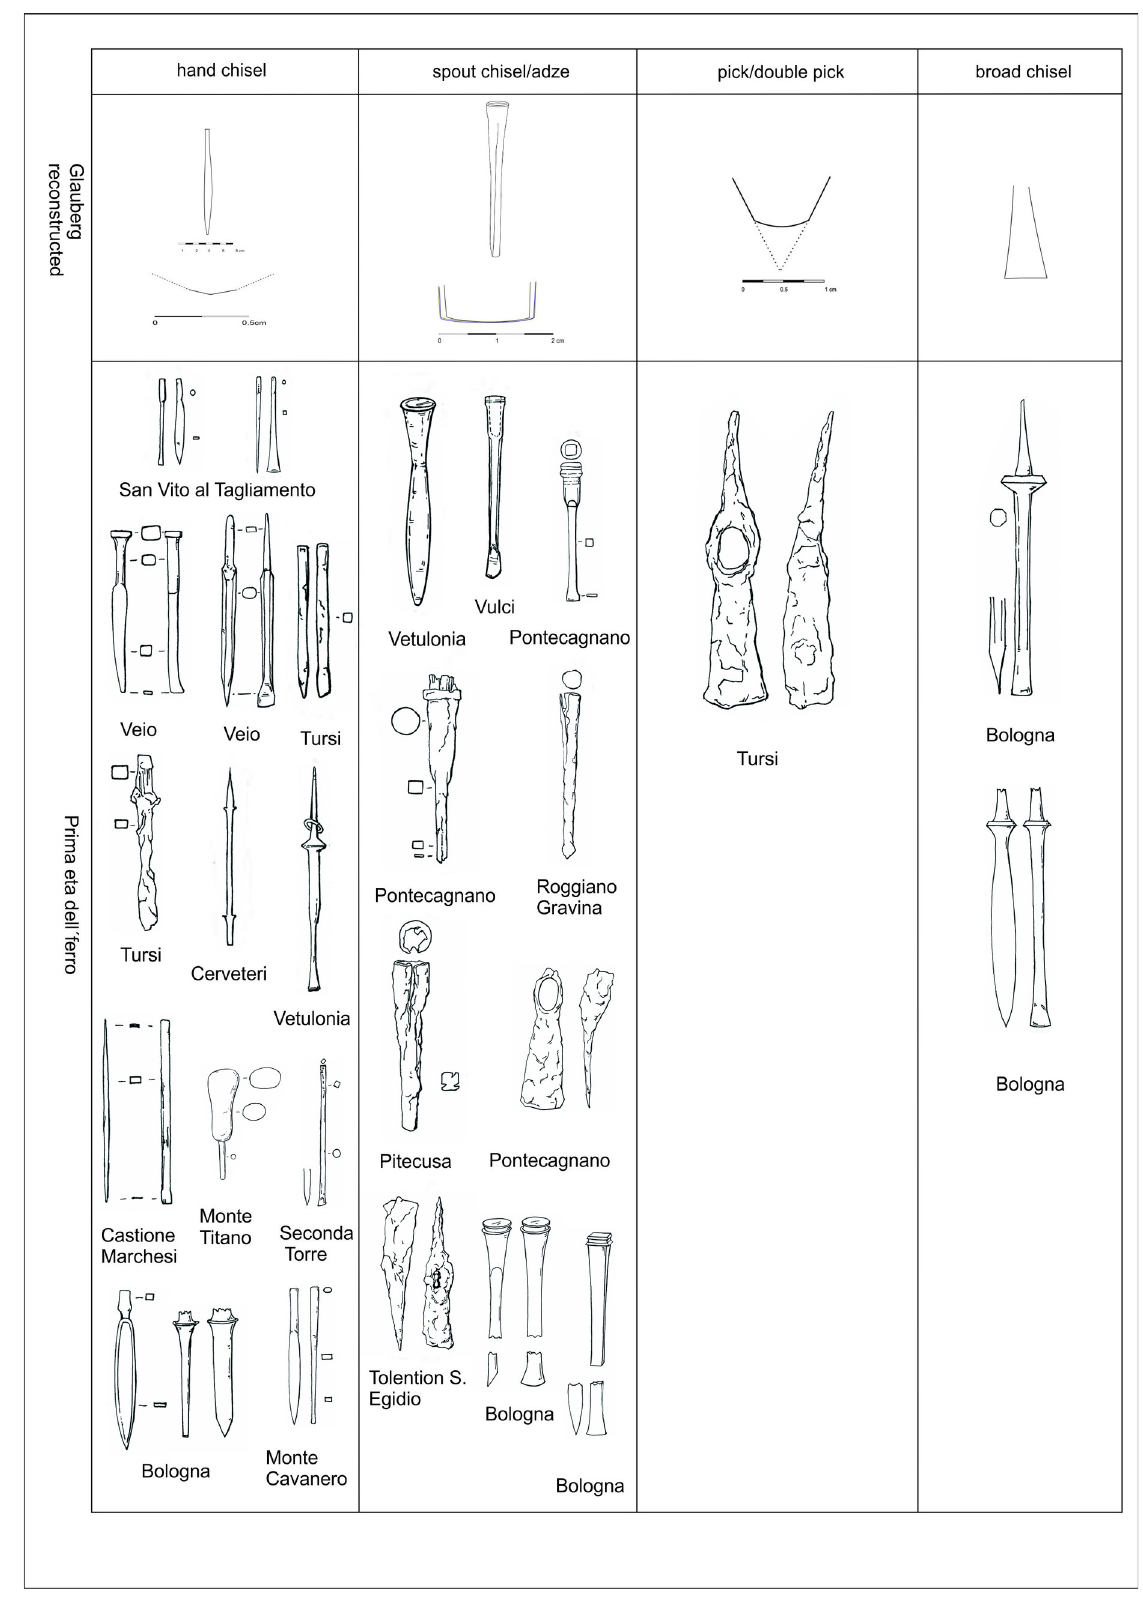
Fig 28. A comparative table of the reconstructed shapes of tools used during the sculpting of Glauberg fragments and the examples of tools from Italy (individual finds are not depicted in the same scale) (author: M. Trefny´ and A. Musilova´). https://doi.org/10.1371/journal.pone.0271353.g028 PLOS ONE | https://doi.org/10.1371/journal.pone.0271353 August 11,